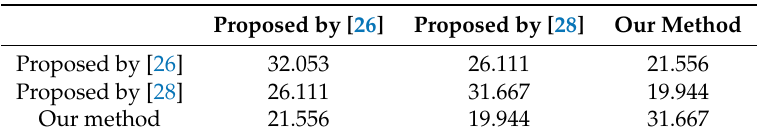
Table 9. Covariance matrix.